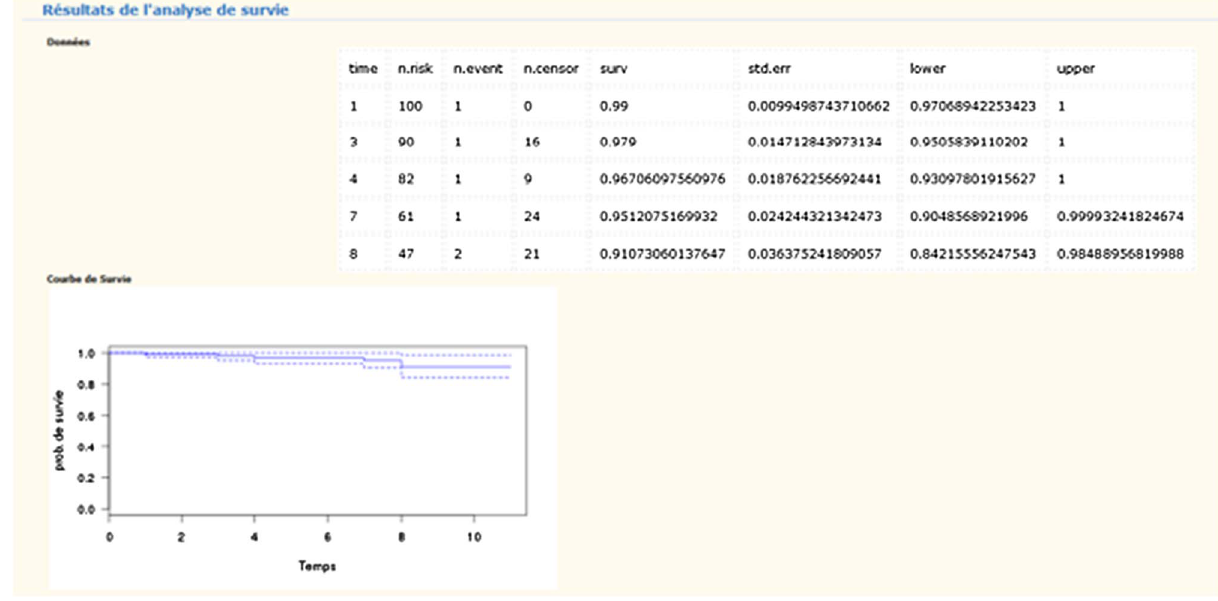
Figure 4. Kaplan – Meier survival